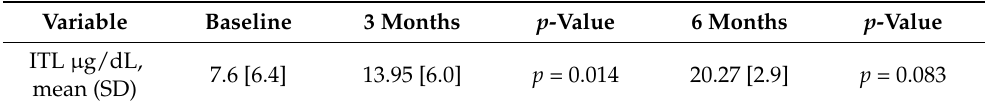
Table 4. Trends in infliximab trough levels in patients with perianal CD.